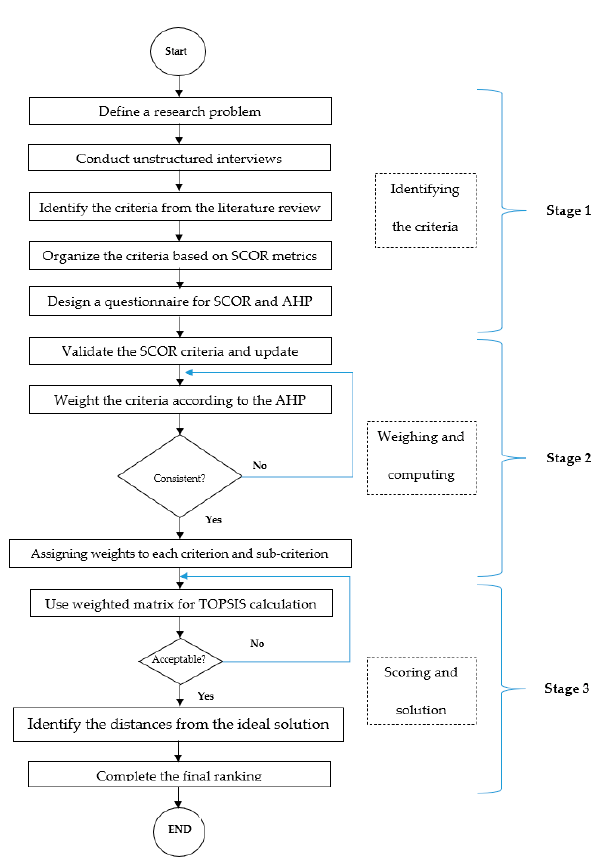
Figure 6. Research design flowchart.